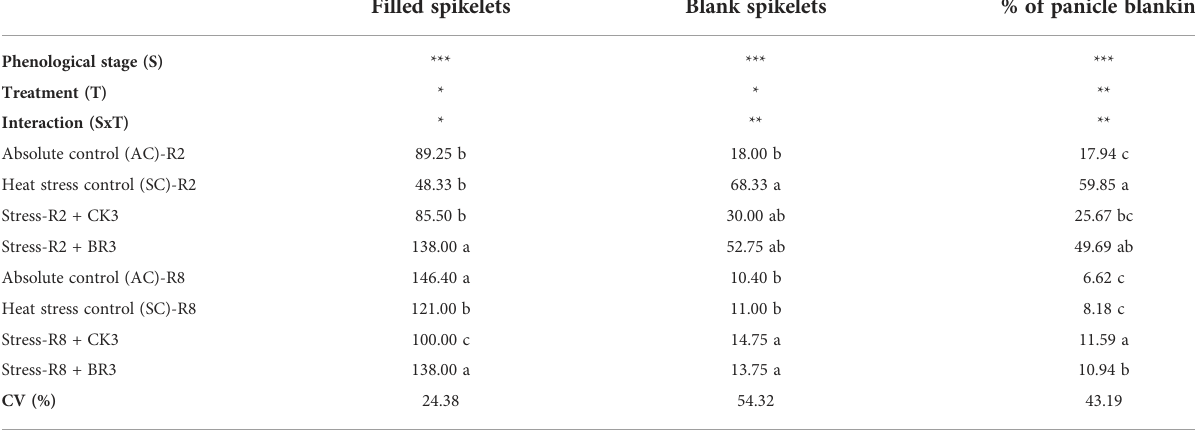
TABLE 6 Effect of the applications of two growth regulators (cytokinins (CK) or Brassinosteroids (BR)) on photosynthetic variables of rice plants of the genotype Federarroz 2000 subjected to combined heat stress (40°C day/30°C night) at 88 and 120 days after emergence (DAE). Filled spikelets Blank